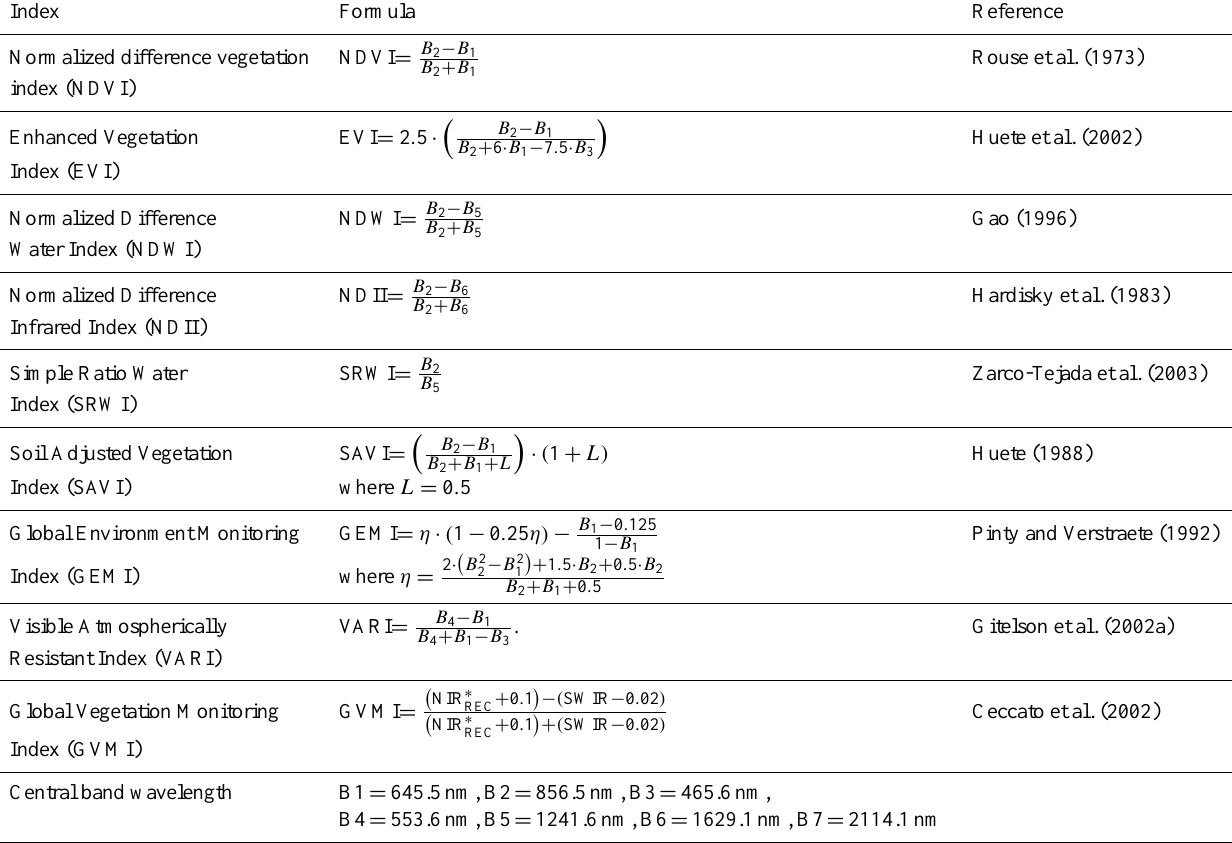
Table 1. Spectral indices calculated using field HCRF measurements and MODIS data. B x designates the band number corresponding to the MOD09GA product surface reflectance